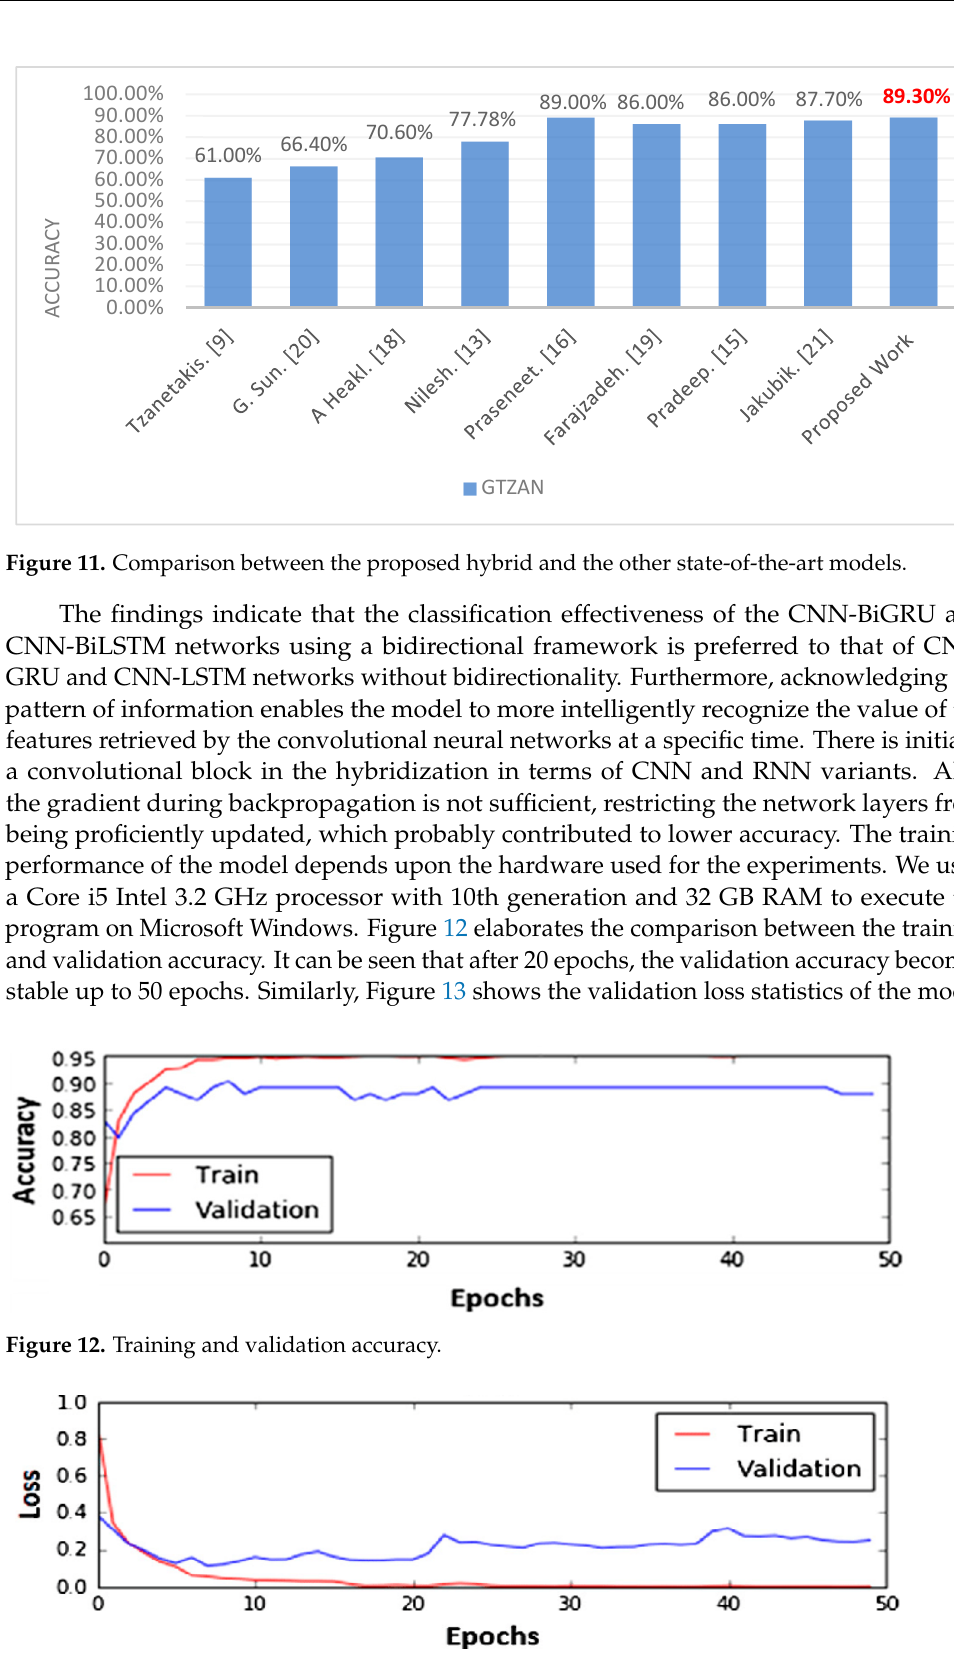
Figure 13. Training and validation loss .